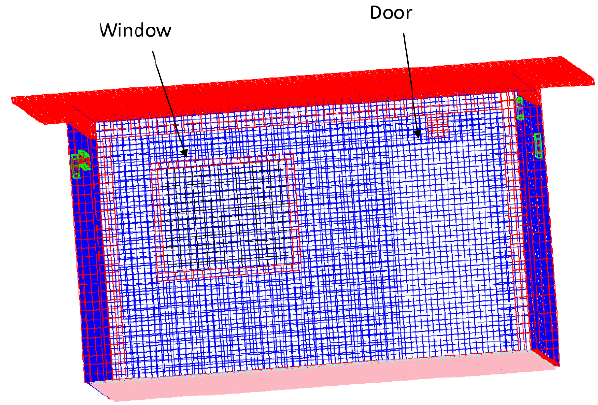
Figure 4. The meshed structure generated on Cast3m.